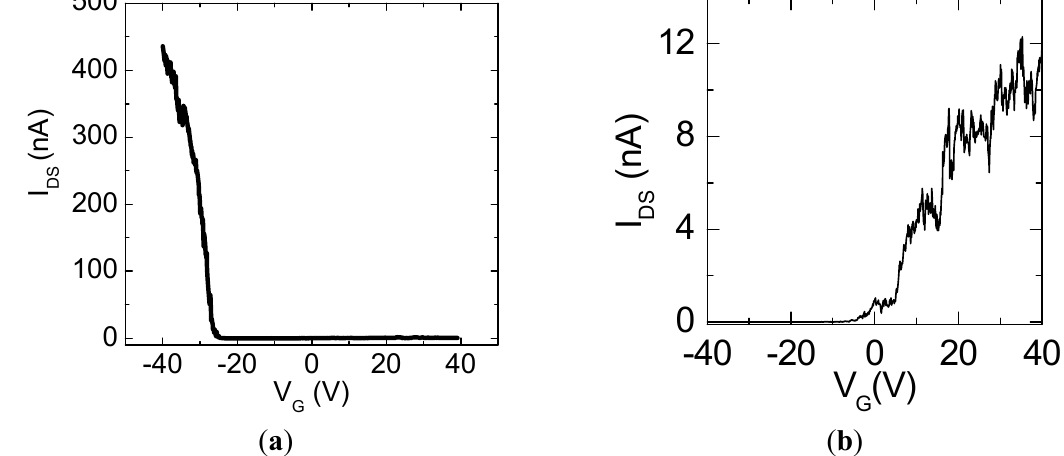
- V curve measured with V DS G